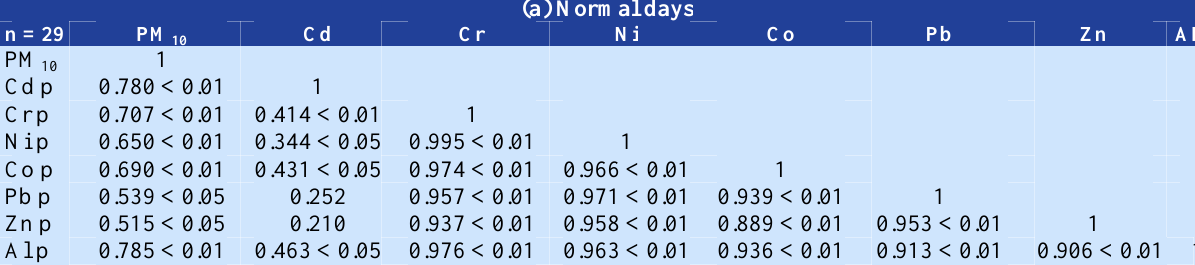
Table 3. Correlation coefficients between concentrations of PM10 and the heavy metals in PM 10 on normal and dusty days in the ambient air of Ahvaz, Iran (a) Normal days